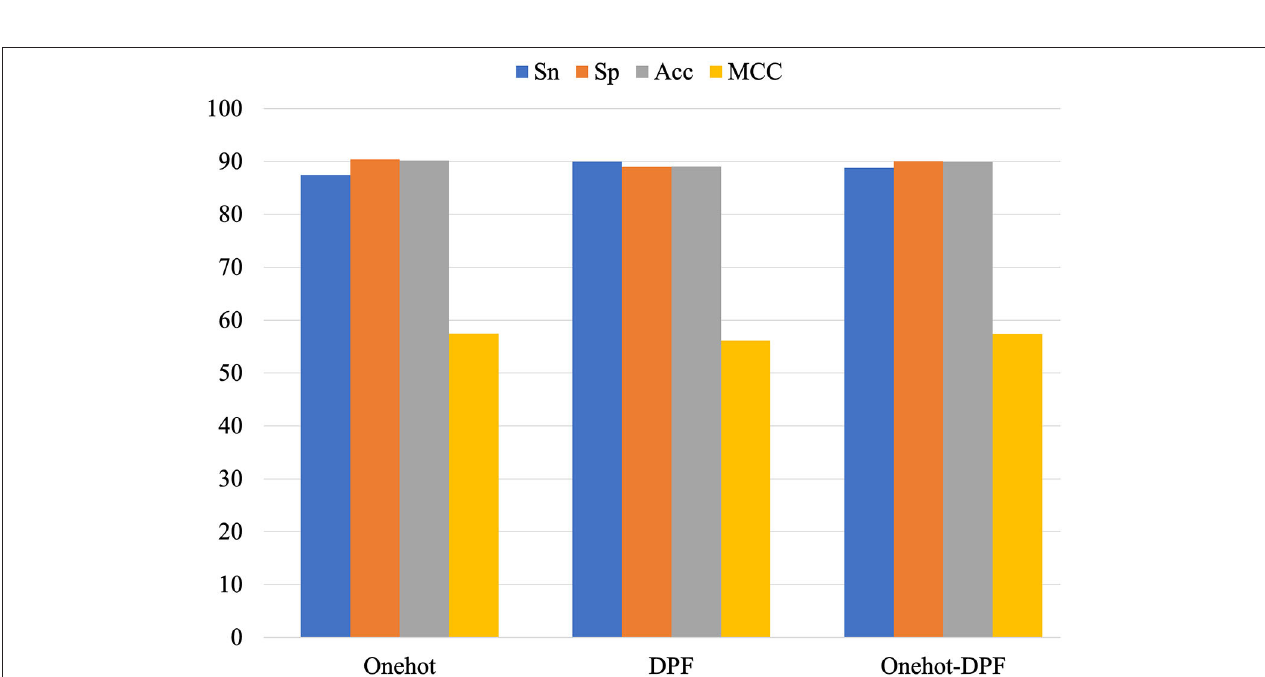
FIGURE 5 | Performance of different feature extraction methods for prediction of 5mC sites.